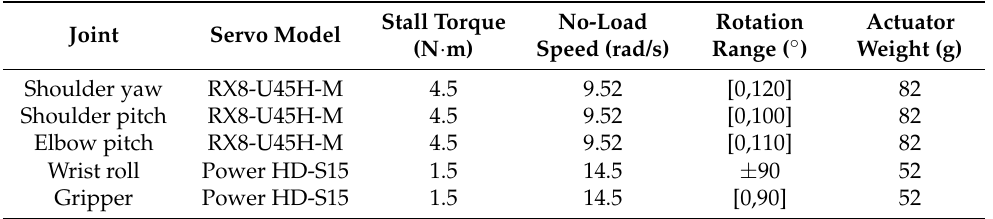
Table 1. The main parameters of the arm